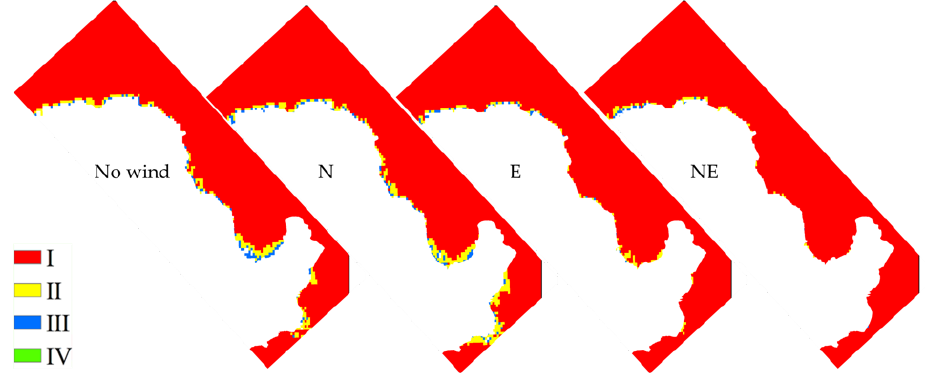
Figure 14. Storm surge risk levels in the YRD with 100-year return period winds in different directions.